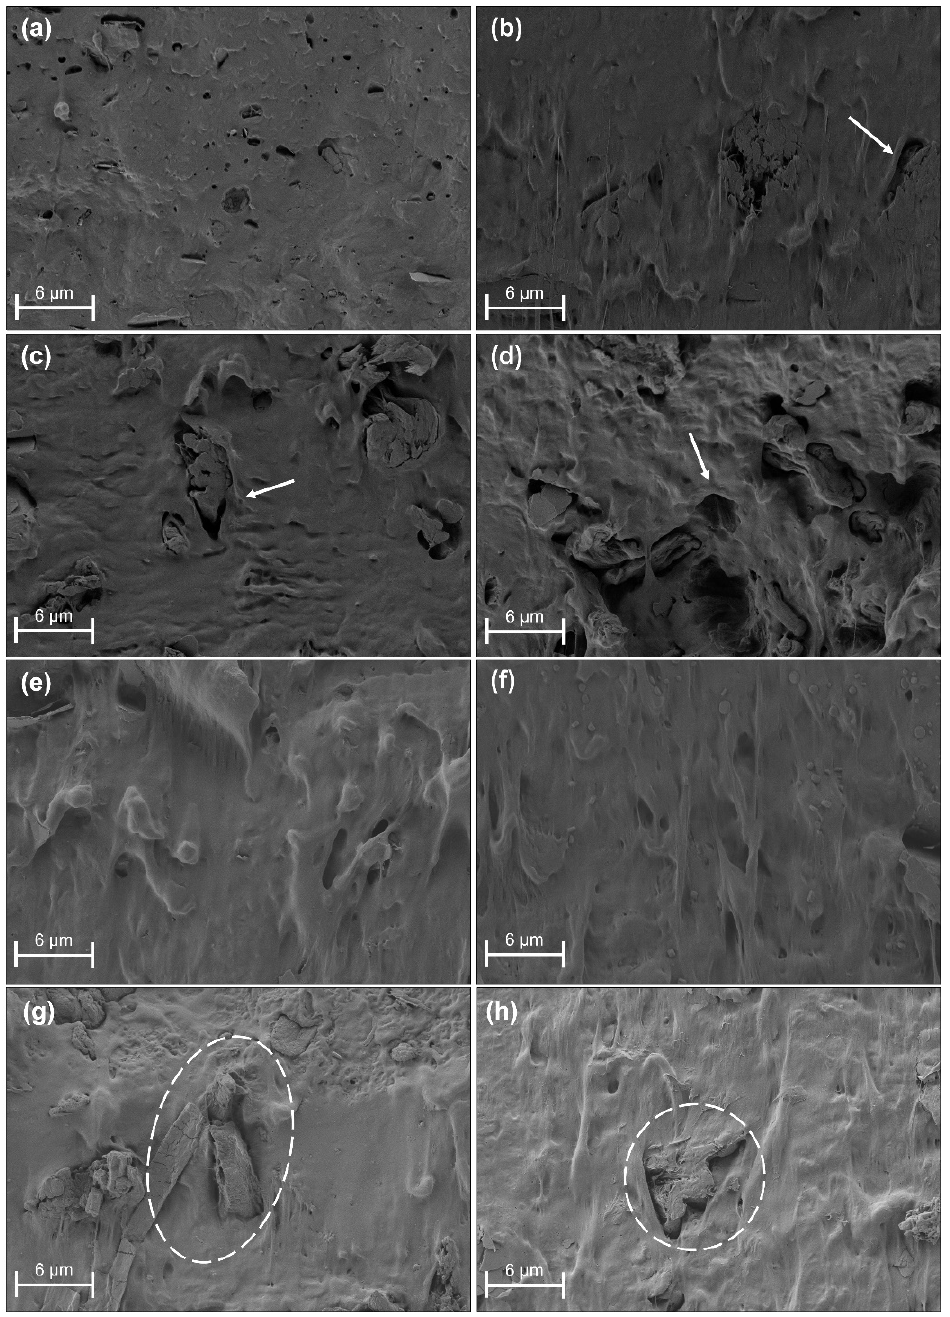
Figure 8. Field emission scanning electron microscopy (FESEM) images of the films of poly(3- hydroxybutyrate- co -3-hydroxyvalerate) (PHBV) with microfibrillated cellulose (MFC) and com- patibilized with epoxy-based styrene-acrylic oligomer (ESAO) and with triglycidyl isocyanurate (TGIC) and dicumyl peroxide (DCP) as follows: ( a ) PHBV; ( b ) PHBV_2.5%MFC; ( c ) PHBV_5%MFC; ( d ) PHBV_10%MFC; ( e ) PHBV_ESAO; ( f ) PHBV_TGIC+DCP; ( g ) PHBV_5%MFC_ESAO; ( h ) PHBV_5%MFC_TGIC+DCP. Arrows and circles show the morphologies described in the